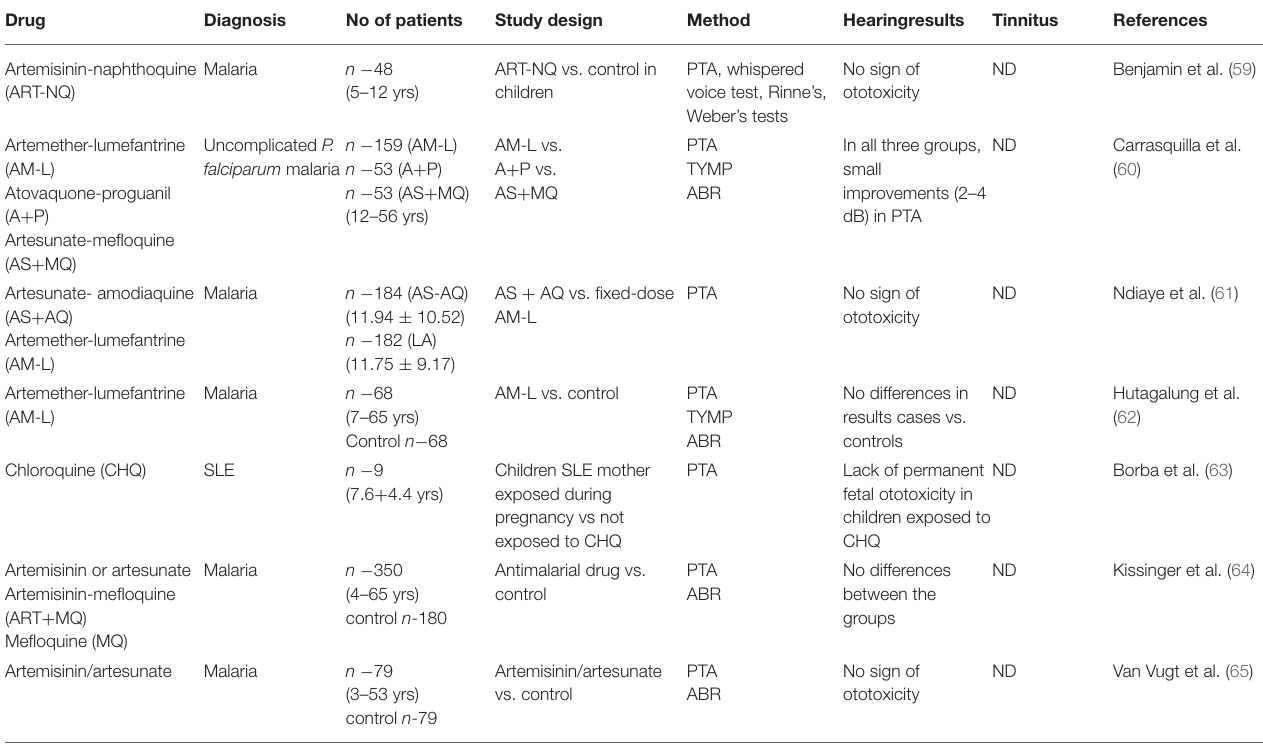
TABLE 3 | Drugs not associated with cochlear